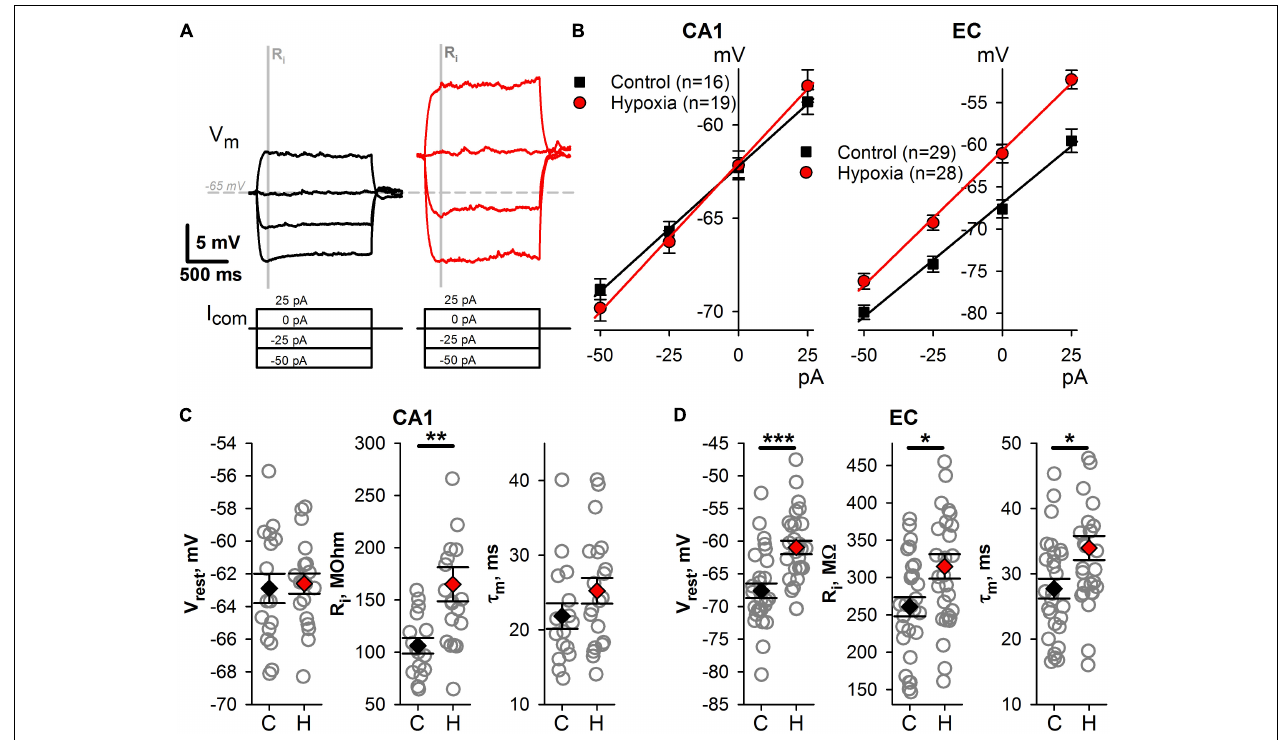
FIGURE 4 | Changes of intrinsic membrane properties of CA1 and EC neurons after prenatal hypoxia. (A) A representative example of subthreshold responses to current steps from –50 to +25 pA. The gray bar indicates the time interval (50 ms) which was used to obtain averaged values of membrane potential for V–I relationships. (B) The averaged V–I relationships of hippocampal (left panel) and cortical (right panel) neurons in the control group and the group after prenatal hypoxia. (C,D) Plots demonstrating the average values of subthreshold parameters of CA1 (C) and EC (D) neurons in control rats (C) and hypoxic rats (H). Asterisks indicate a significant difference between groups according to an appropriate statistical test. * P < 0.05, ** P < 0.01, *** P <